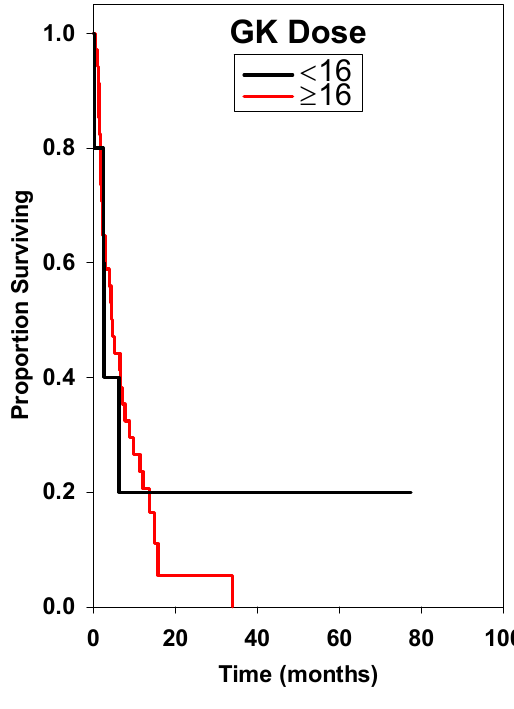
Figure 7. Survival curve comparing Gamma Knife (GK) radiotherapy dose or brainstem metastasis (<16 Gy vs. ≥ 16 Gy). There was no statistically significant difference among these